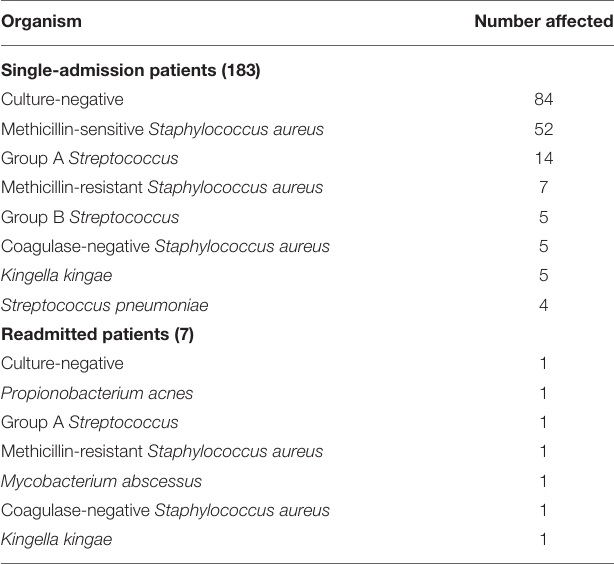
TABLE 2 | Causative organisms in single-admission patients and readmitted patients. Organism Number